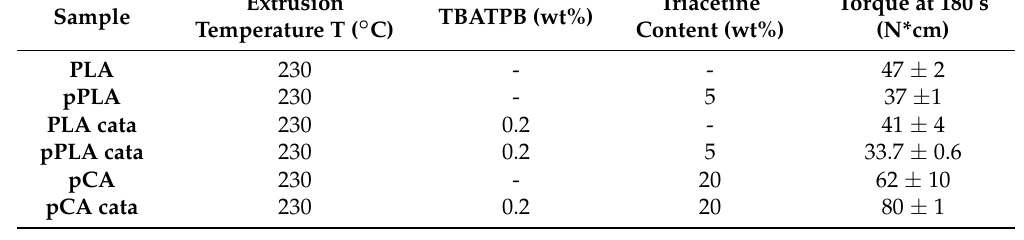
Table 2. Reference extrusion experiments carried out at 230 °C. pPLA = plasticized PLA; N*cm = N·cm.